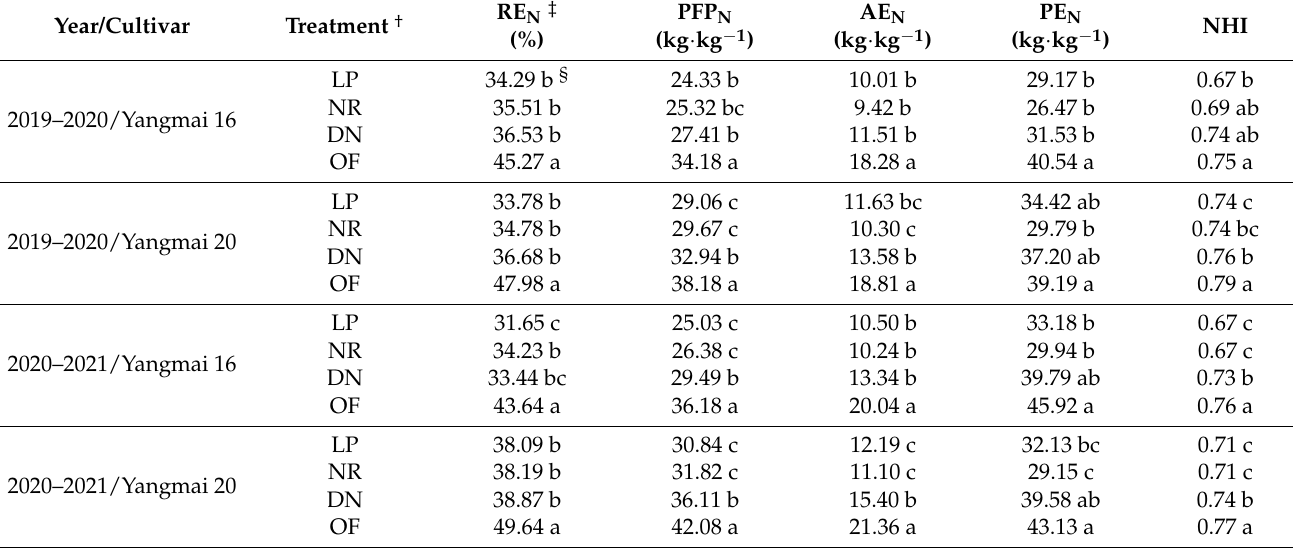
Table 2. Effects of integrated cultivation practices on nitrogen use efficiency and nitrogen harvest index.